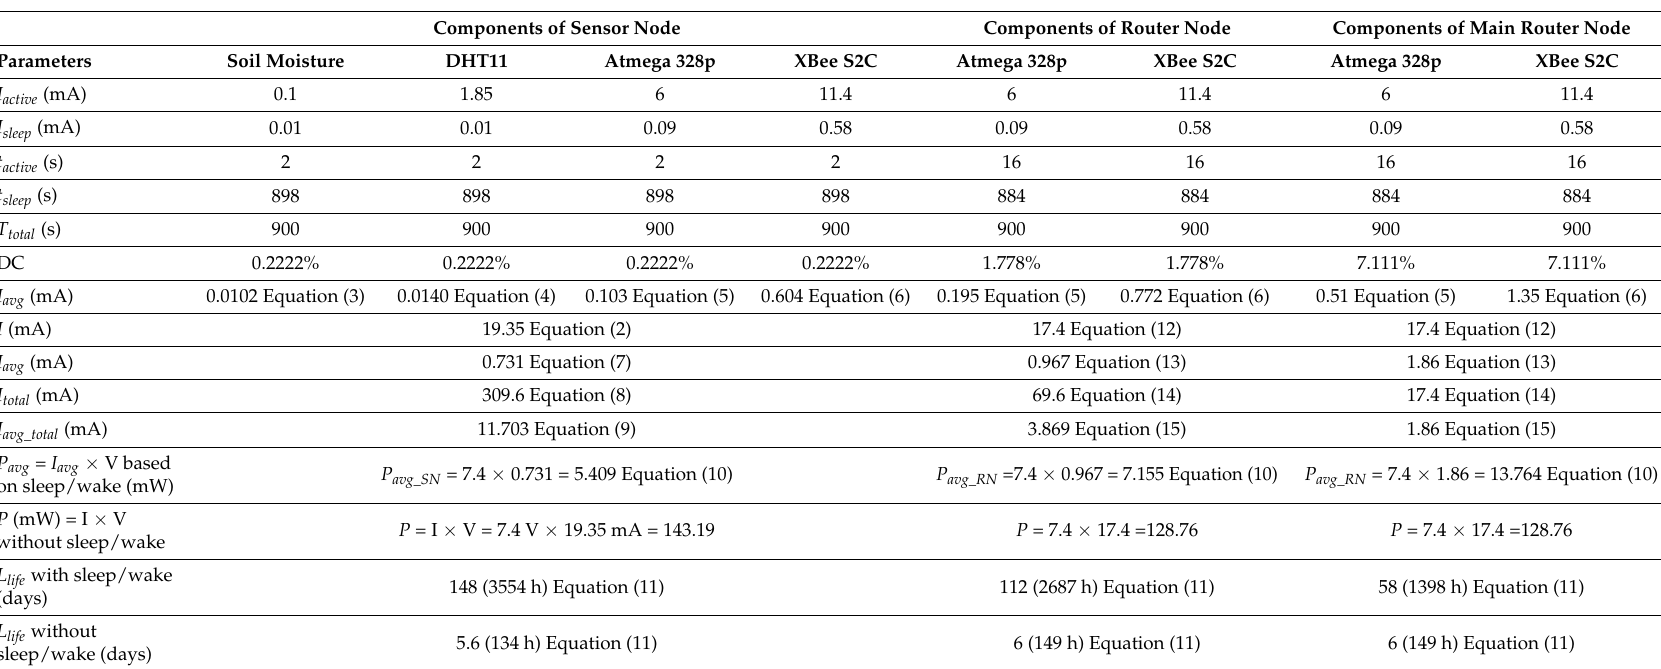
Table 4. Current consumption and time profile of the sensor, router, and main router